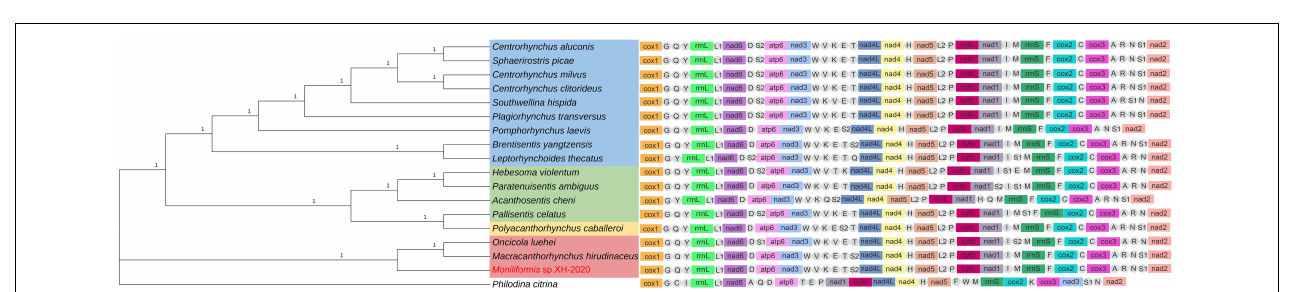
FIGURE 6 | Phylogenetic relationship of Moniliformis sp. XH-2020 with other acanthocephalans based on the concatenated amino acid sequences of 12 PCGs by Bayesian inference and mt gene order. Node values are Bayesian posterior probabilities (BPP), the red color indicates the class Archiacanthocephala, the green color indicates the class Eoacanthocephala, the blue color indicates the class Palaeacanthocephala, the yellow color indicates the class Polyacanthocephala, the tRNAs are labeled by single-letter code for the corresponding amino